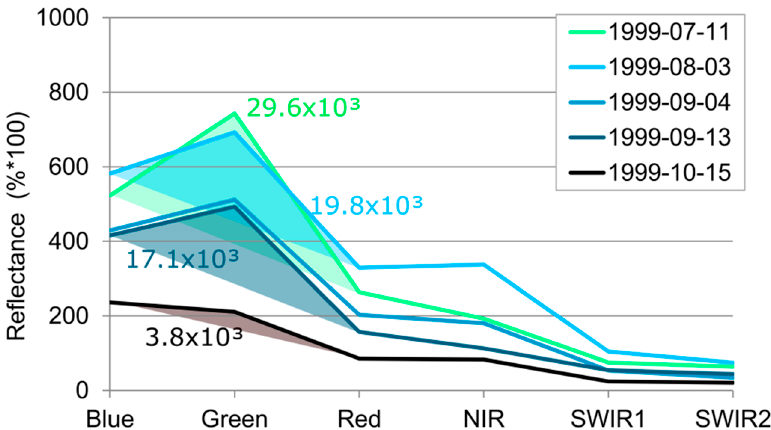
Figure 10. Reflectance spectra of BL with calcite precipitation (11 July 1999), diminishing calcite precipitation (3 August 1999 to 13 September 1999), and without calcite precipitation (15 October 1999). The ROI that has been used for the extraction and calculation of the mean reflectance spectra of BL is marked in Figure 7. The transparent triangles and colored numbers illustrate the “Area BGR”.